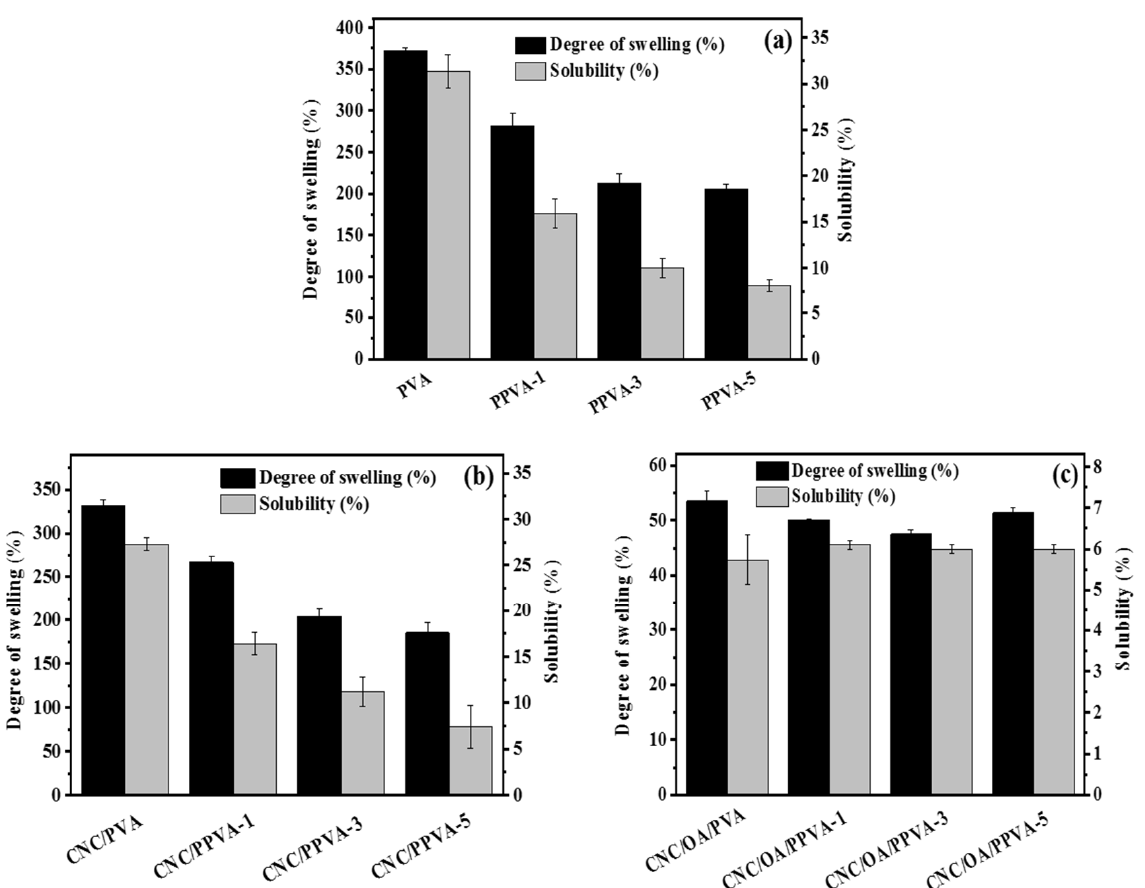
Figure 2. The degree of swelling and solubility of different films without or with air plasma treat- ment. ( a ) PVA and its air plasma-treated films; ( b ) CNC/PVA and its air plasma-treated films; ( c ) CNC/OA/PVA and its air plasma-treated films.